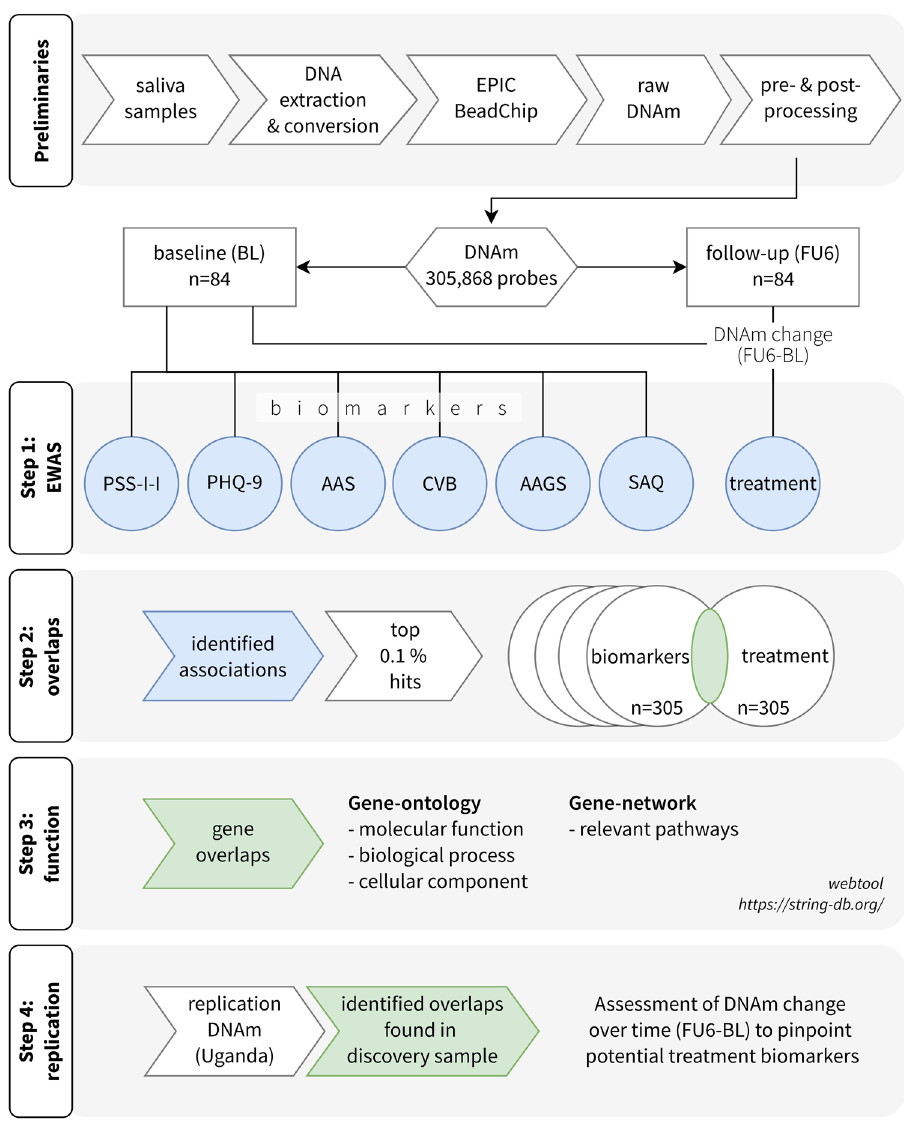
Figure 4. Scheme of study methodology. From top to bottom, diagram shows the four main steps of data analysis, after preliminary data collection and processing. Step 1: epigenome-wide association analysis to identify biomarkers for clinical and social outcomes considering baseline data only. Treatment association considered DNAm change accounting for baseline and follow-up data. Step 2: extraction of CpGs and genes from identified associations and test for intersections. Step 3: gene-ontology and gene-network analysis was conducted for those associations where treatment and other outcomes had overlapping results to infer relevant body functions. Step 4: replication of results in an independent sample using linear models and observing directionality and intensity of methylation